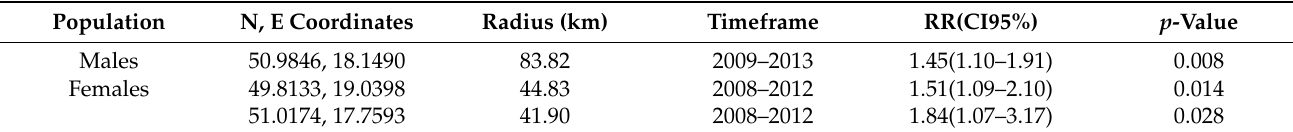
Table 1. Statistically significant ( p < 0.05) spatio-temporal cutaneous MM disease clusters in Upper Silesia (2004–2013) in males and females ( ≥ 60).